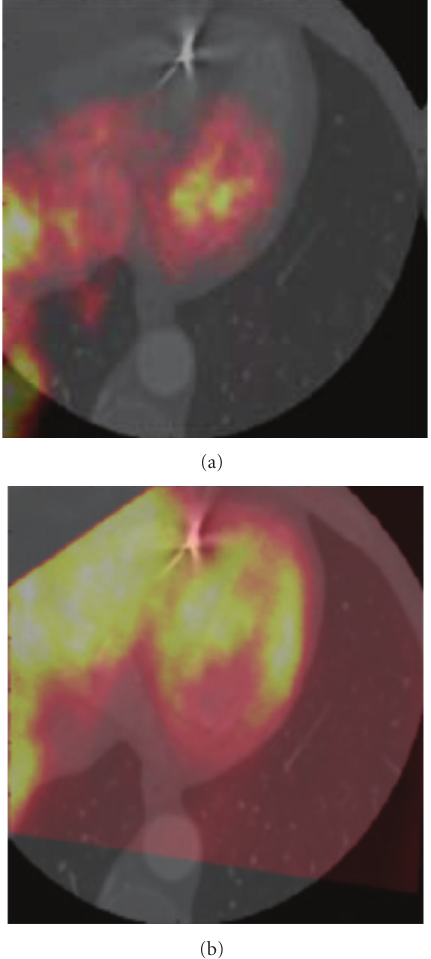
Figure 8: Example of misaligned (a) and aligned (b) transaxial PET and CT images in which an artifact caused by a metallic object is